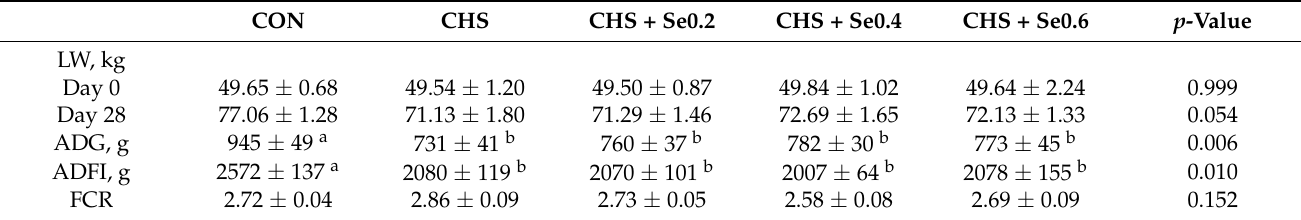
Figure 1. Temperature ( ◦ C) ( A ), relative humidity ( B ) and temperature humidity index ( C ) inside the climate chamber. TN, thermoneutral condition; HS, heat stress condition. Table 2. Effects of CHS and OH-SeMet supplementation on growth performance of growing